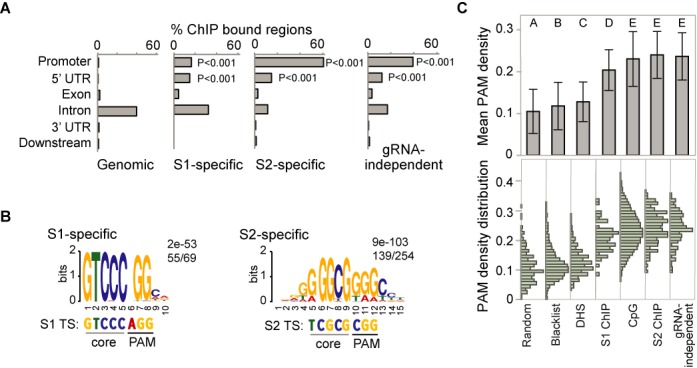
Identification of G- and C-rich motifs at off-target binding sites correlates with increased PAM motif density. (A) Location analysis of ChIP-seq binding sites. ChIP peaks at gene-proximal regions and within gene bodies were analyzed using Cis-regulatory element annotation system (CEAS). Gene-proximal regions include promoters up to 1 kb upstream of the transcription start site and regions up to 1 kb downstream of the transcription termination site. Binding within gene bodies is divided into four functional categories: 5′UTRs, exons, introns and 3′UTRs. Localization of ChIP regions within these categories is compared with the genome background percentages for the same categories. P-values for the significance of the relative enrichment with respect to the background were calculated using one-sided binomial test and are indicated for categories with significant enrichment in ChIP samples as compared to genomic background. The remaining ChIP bound regions do not fall into the above categories and are considered ‘distal intergenic’ regions. No significant enrichment was observed at distal regions as compared to background. (B) Identification of de novo motifs for overlapping dCas9 binding sites in Neuro-2a cells. MEME-ChIP motif analysis using the central 100 bp of S1 and S2 gRNA-specific ChIP-seq binding regions reveals the indicated motif. The statistical significance of the motif is indicated by E-values, as output by MEME-ChIP. The number of sequences containing the identified motif relative to the total number of binding sites is indicated. The 5-bp core sequences and PAM for the target sites (TS) are shown. (C) PAM density plot based on occurrence of NGG in 100-bp regions in the genome. Both DNA strands were scanned for the three-nucleotide motif. PAM density of the central 100 bp of gRNA-specific and gRNA-independent ChIP-seq peaks was determined for S1-specific (n = 69), S2-specific (n = 254) and gRNA-independent (n = 150) binding sites, Randomly selected 100-bp regions of the mouse genome (n = 340) and an array (n = 3038) of artefact peaks (also known as ENCODE ChIP-seq blacklist) were used as a control. PAM density was also calculated for CpG islands (n = 16026) and DNase I hypersensitive sites (DHS, n = 469 449). Mean of PAM density +/− standard deviation is shown in the top panel and statistical groupings A-E as determined by student's t-test are indicated above each column. Different letters indicate statistically different means between samples. PAM density distribution is plotted in the lower panel.